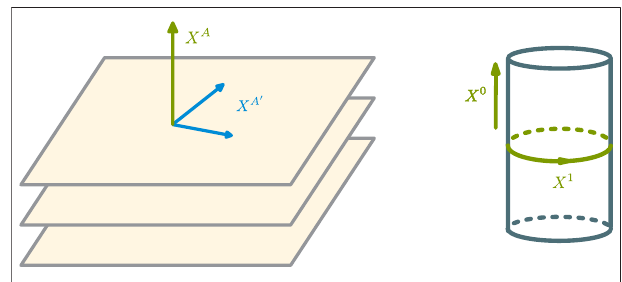
FIGURE 1 | A schematic illustration of the longitudinal and transverse fi elds X A and X A ′ in the NR string action. The green arrows represent the two longitudinal directions X A . Each horizontal slice represents the ( d − 2)- dimensional transverse directions X A ′